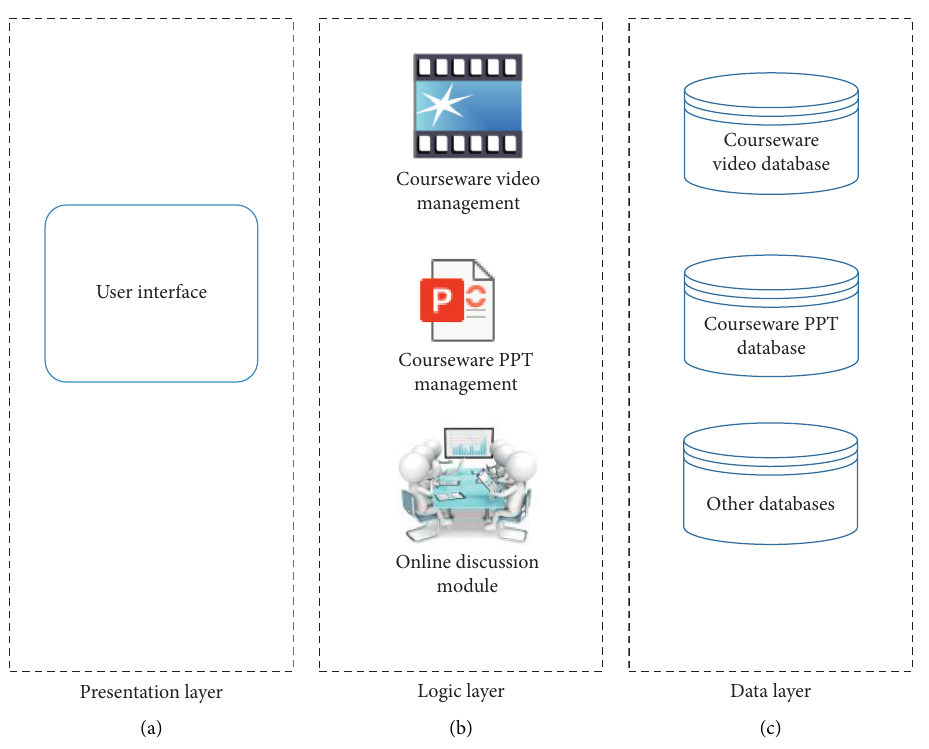
Figure 4: The software layer architecture diagram of the I&P teaching